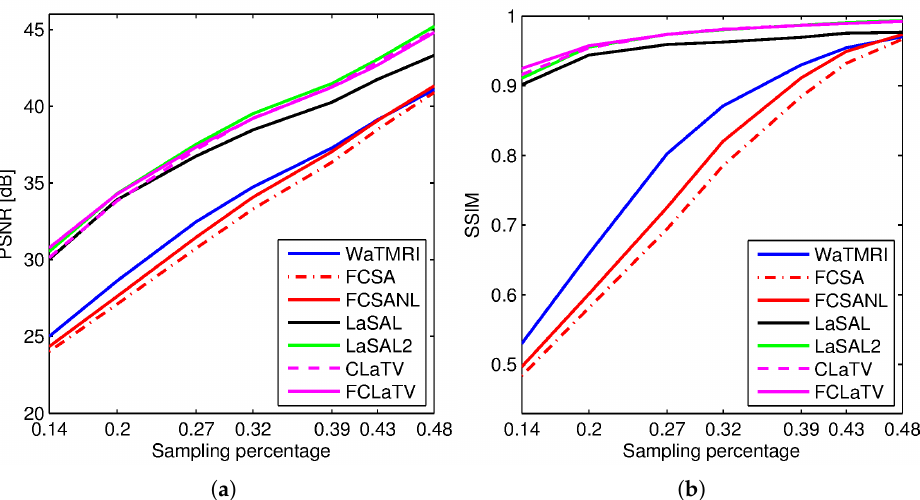
Figure 3. ( a ) PSNR and ( b ) SSIM for the reconstructions of the test image sagittal at different sampling